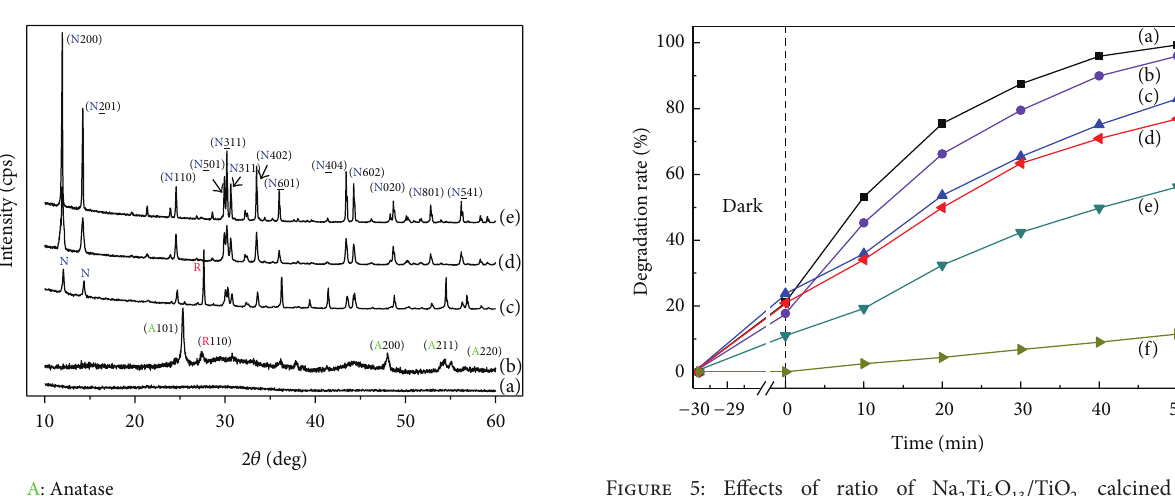
Figure 5: Effects of ratio of Na 2 Ti 6 O 13 /TiO 2 calcined at 600 ∘ C: (a) 1.5-Na 2 Ti 6 O 13 /TiO 2 ; (b) 1.0-Na 2 Ti 6 O 13 /TiO 2 ; (c) 0- Na 2 Ti 6 O 13 /TiO 2 ; (d) commercial P25; (e) 2.5-Na 2 Ti 6 O 13 /TiO 2 ; (f) blank.